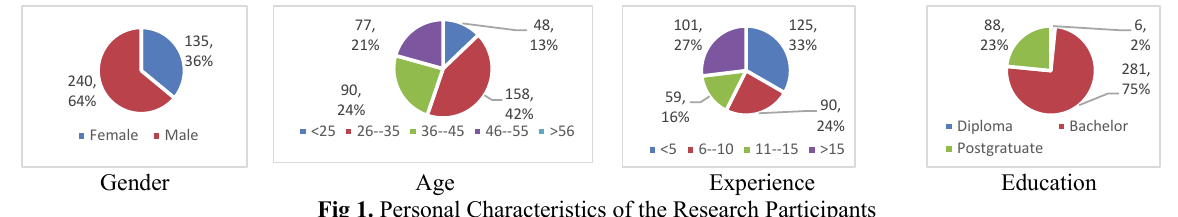
Fig 1. Personal Characteristics of the Research